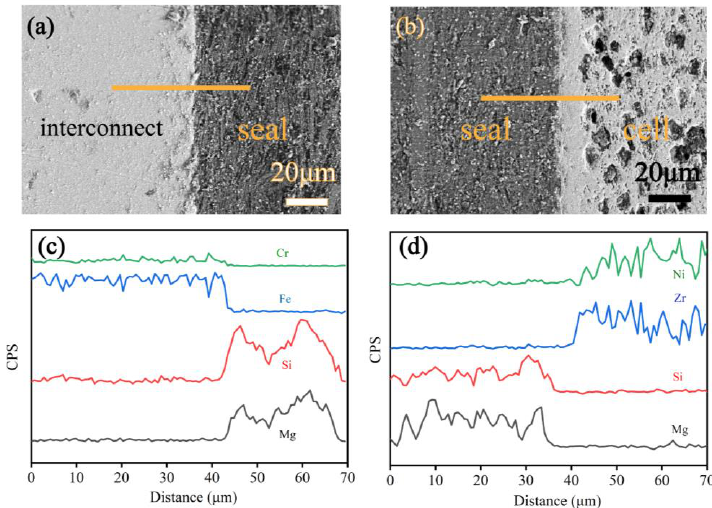
Figure 6. The SEM micrographs and EDS compositional profiles across the interface after 20 thermal cycles, under a compressive load of 0.3 MPa at 750 °C: seal/interconnect interface ( a , c ), seal/anode interface ( b , d ), exhibiting better interfacial compatibility.